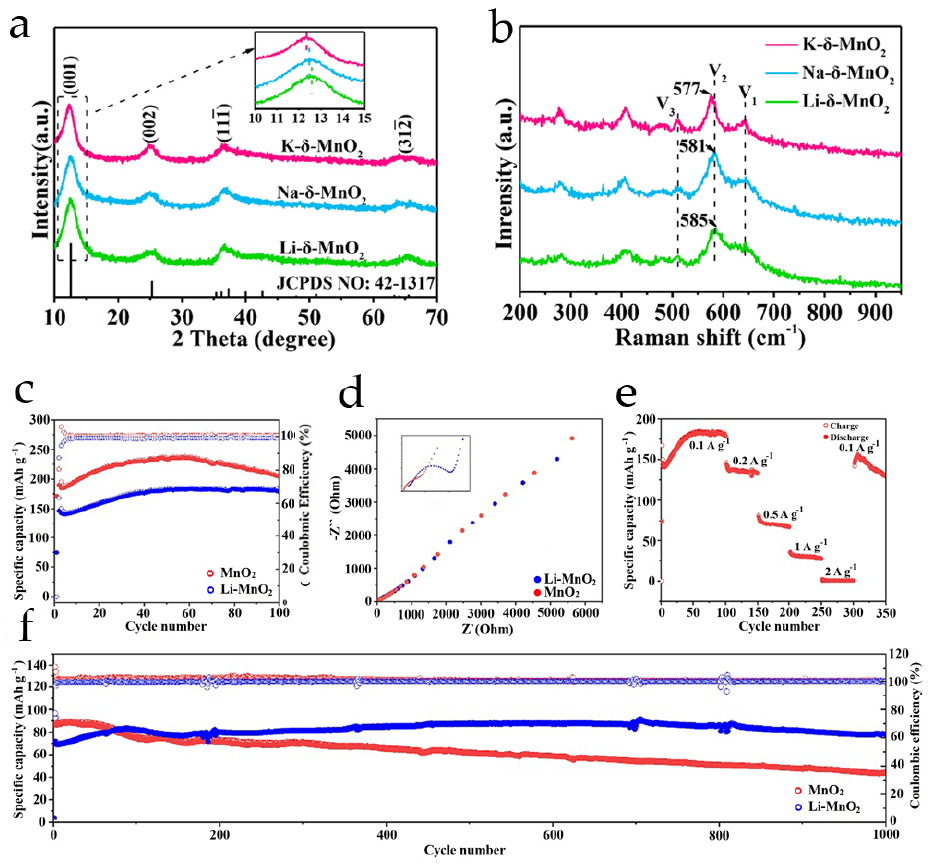
Figure 2. ( a ) XRD patterns and ( b ) cyclic performance at current density 0.3 A · g –1 of X- δ -MnO 2 (X = Li, Na, K) [23]. ( c ) Cycling performance of MnO 2 and Li-MnO 2 electrodes at a current density of 0.1 A g –1 [32]. ( d ) EIS spectra of MnO 2 and Li-MnO 2 at open-circuit voltage [32]. ( e ) Rate performance